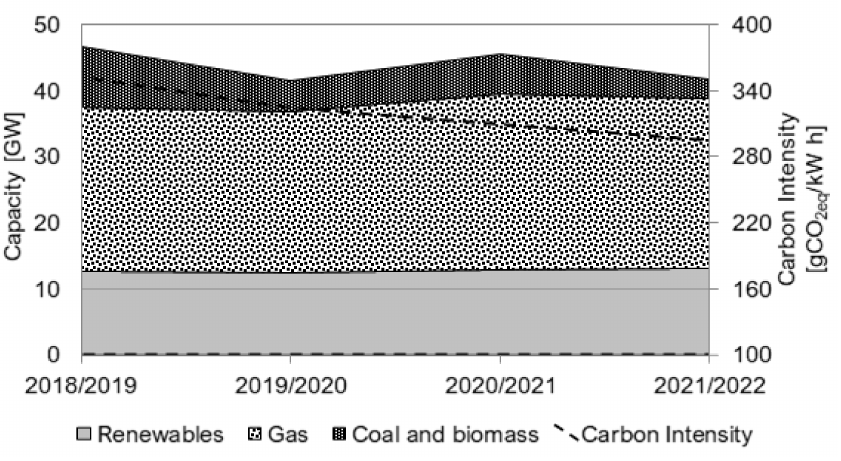
Figure 4. Dispatchable capacity secured in T-4 CM auctions per technology and fuel [56,58–60] and estimated CI.